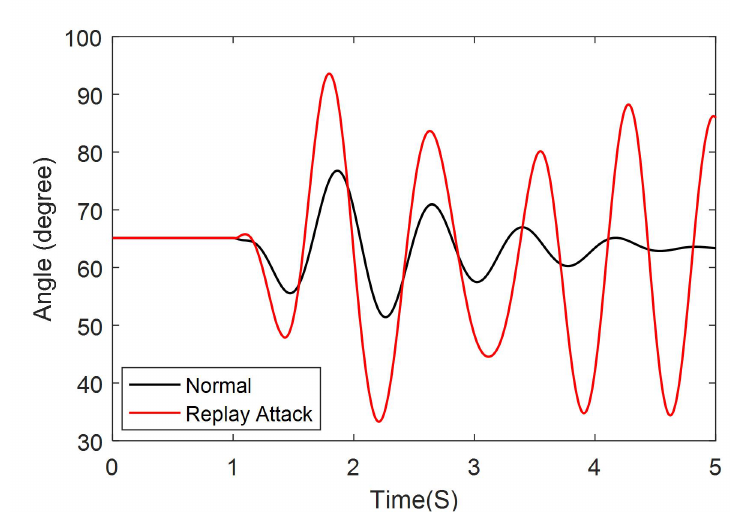
Figure 11. Machine 5–8 angle differences under the replay